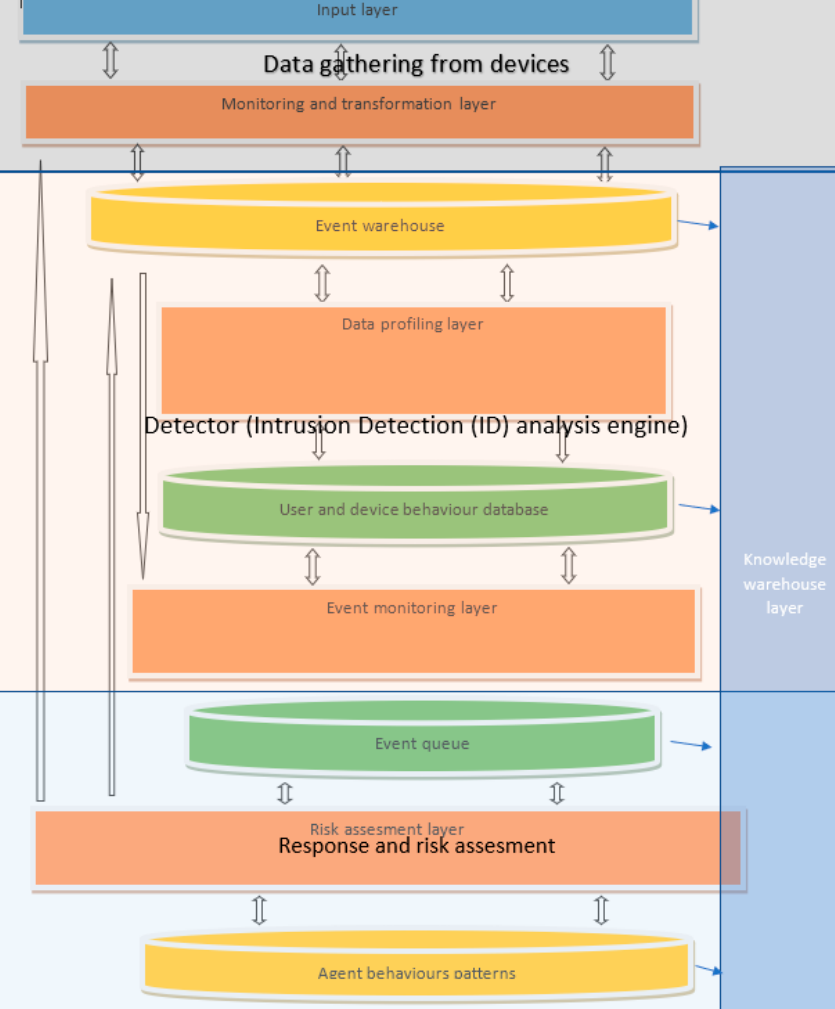
Figure 3. The reference structure of an agent-based IDS/IPS.